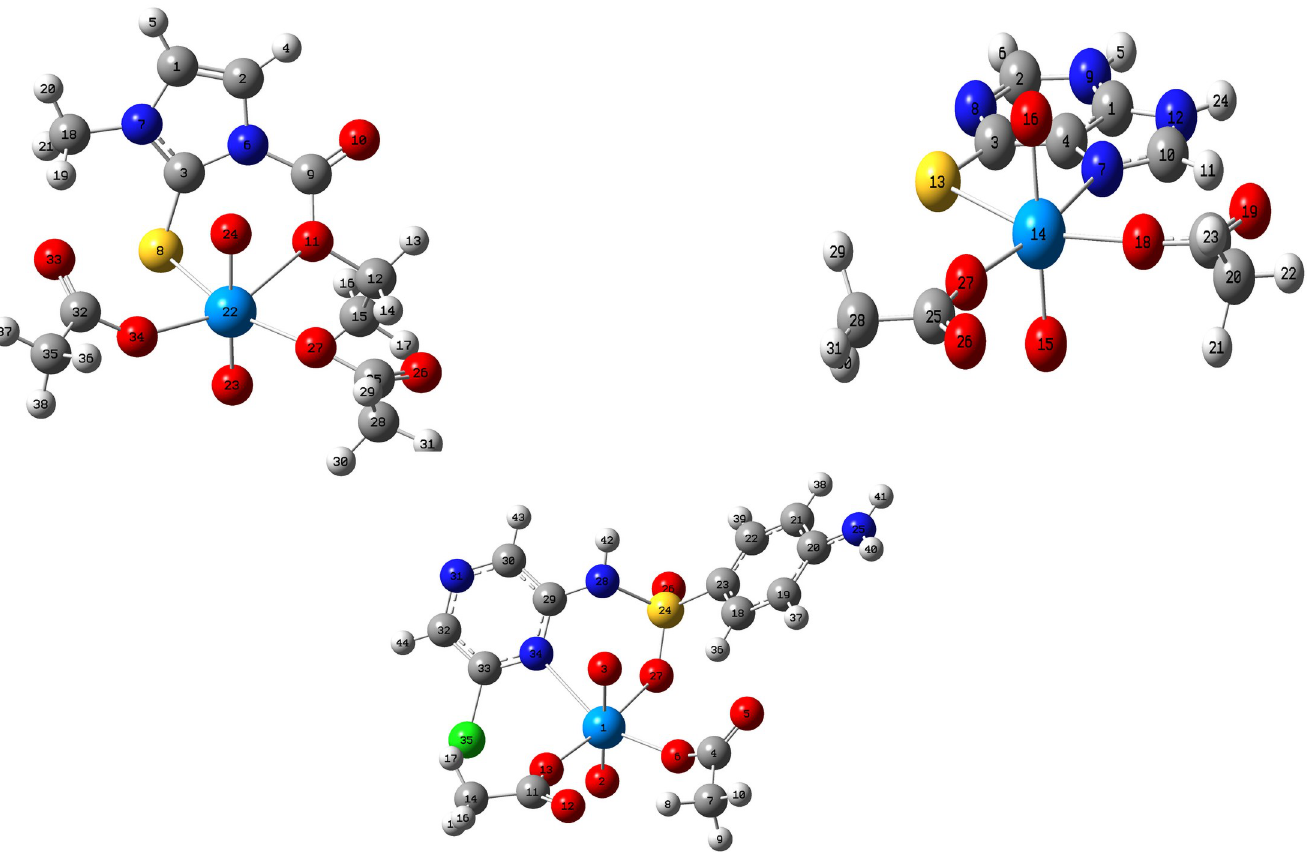
Fig 2. The optimized geometry and numbering system for uranayl metal